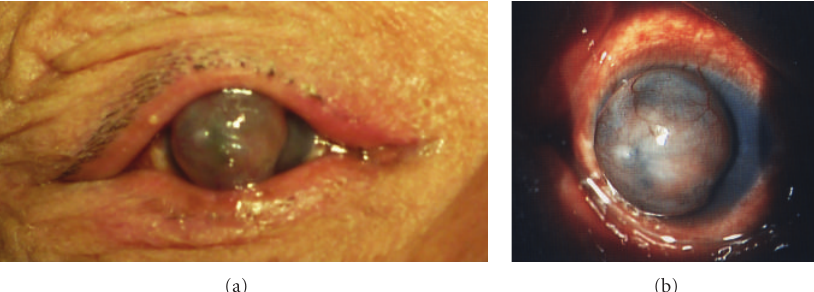
Figure 1: (a) The corneal bulge between the eyelids in a 62-year-old male. (b) Slit lamp photograph showed that the right cornea had the appearance of a smooth-surfaced opacified and vascularized protrusion bulging anteriorly.